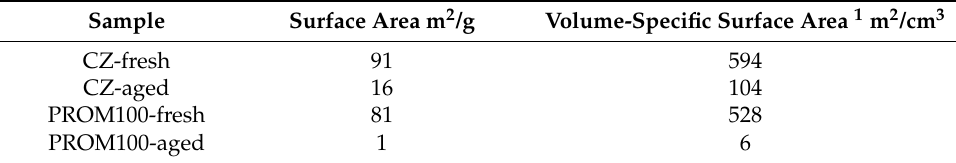
Table 2. Textural properties of the CZ support and the PROM100